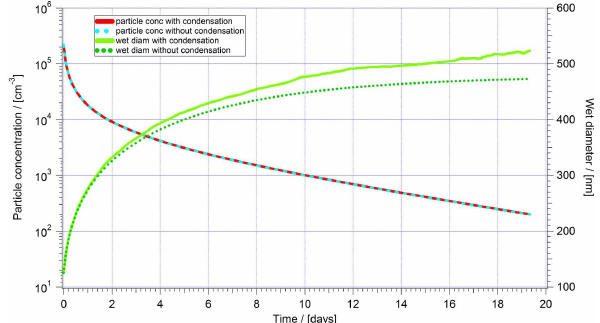
Fig. 10. Time sequence of the modeled number concentrations of smoke particles in the plume parcel, with and without con- sidering condensation (left axis). Time sequence of the modeled smoke particle diameter D sp for two cases: without and with binary H 2 SO 4 − H 2 O condensation (right axis).